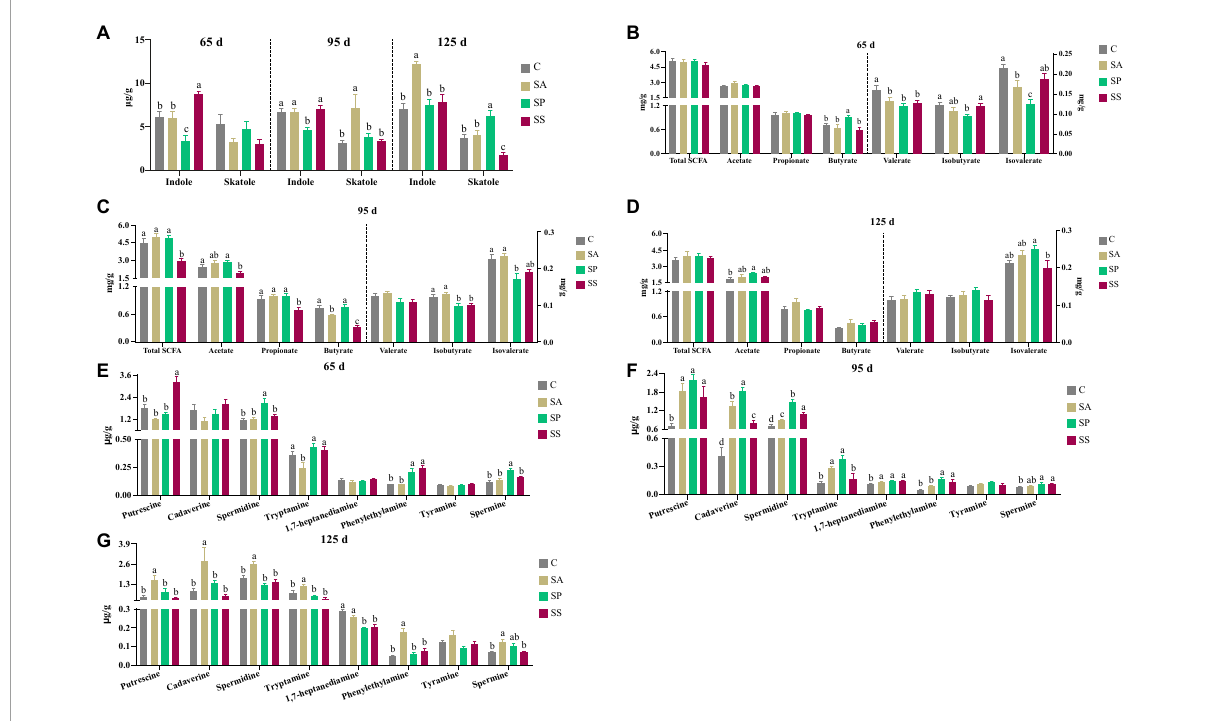
FIGURE11 Concentrations of indole, skatole, short-chain fatty acids (SCFAs), and bioamines in colonic contents of offspring pigs at 65, 95, and 125 days of age. Concentrations of indole and skatole in colonic contents at 65, 95, and 125 days of age (A) ; concentrations of SCFAs in colonic contents at 65, 95, and 125 days of age (B–D) , respectively; and concentrations of bioamines in colonic contents at 65, 95, and 125 days of age (E–G ), respectively. Different superscript letters mean a significant difference ( P < 0.05). 65 d, 65 days of age; 95 d, 95 days of age; 125 d, 125 days of age; C, sow fed with basal diet; SA, sow fed with antibiotic; SP, sow fed with probiotics; SS, sow fed with synbiotics.